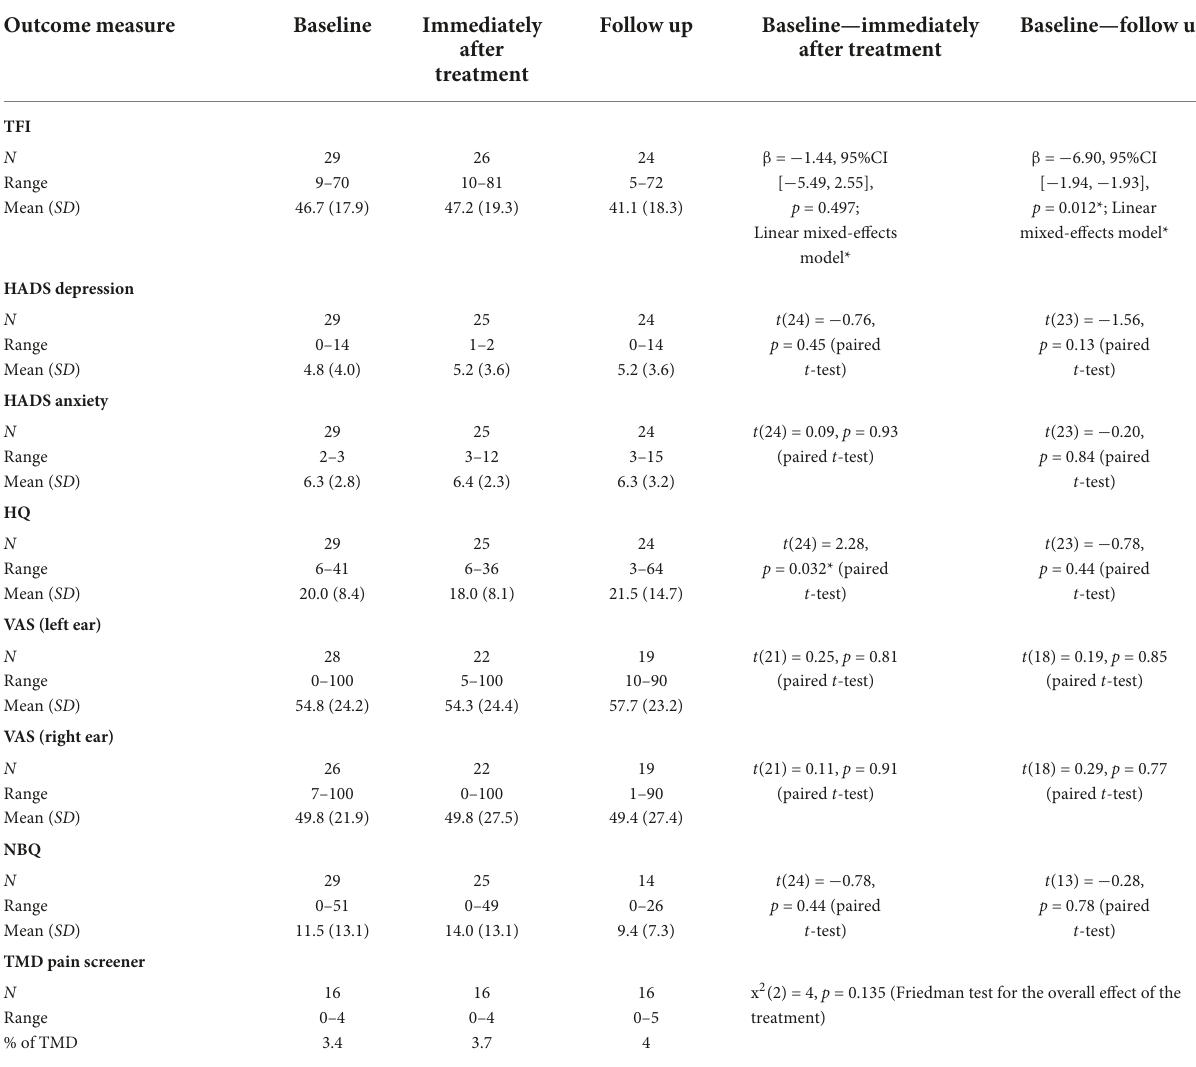
TABLE 1 Effect of treatment on primary and secondary outcome measures. Outcome measure Baseline Follow up Baseline—immediately